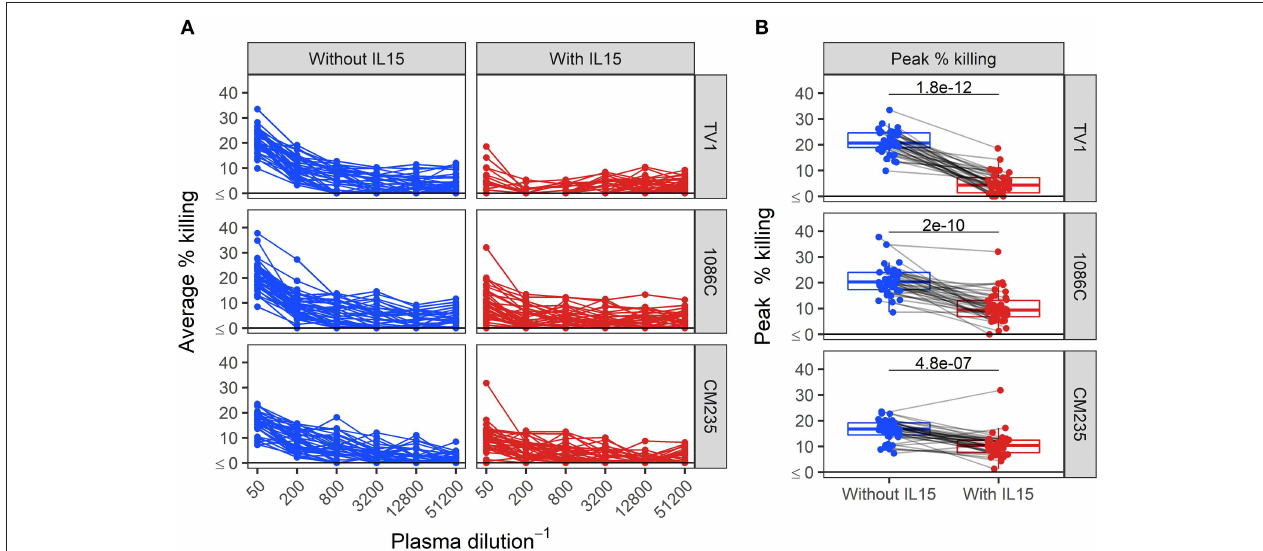
FIGURE 4 | Dilution curves (A) and boxplots of peak % killing (B) of baseline ADCC activity in baseline plasma samples from HVTN 100 participants, with and without IL-15. Unadjusted p -values from paired Wilcoxon rank sum test are reported. Responses from the same sample are connected with gray lines.